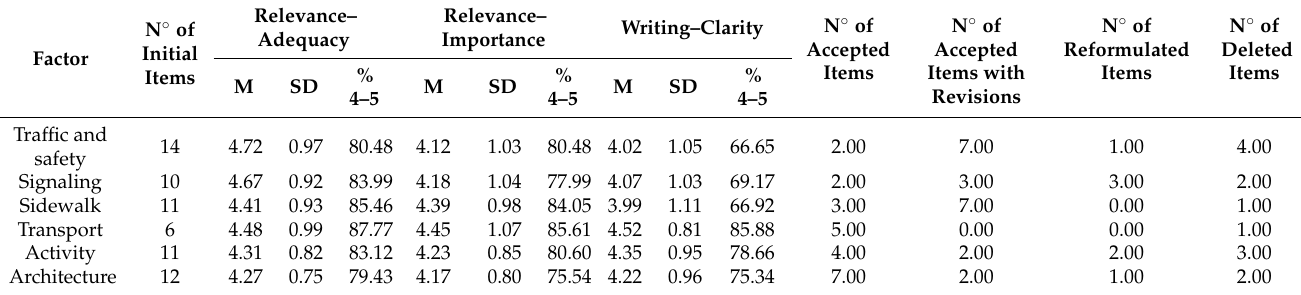
Table 5. Summary of results of round one by